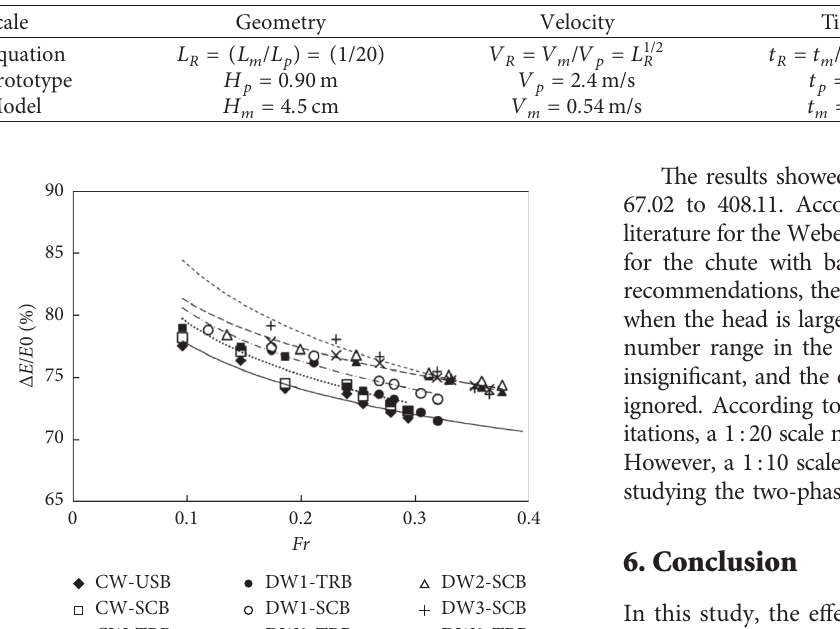
Figure 15: Relative energy dissipation at different Froude numbers upstream of the chute.